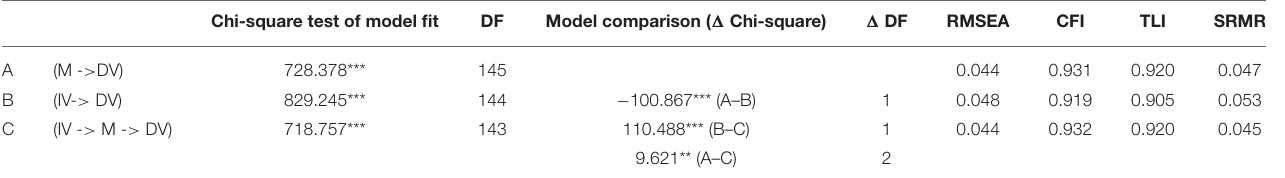
TABLE 3 | Goodness of fit indices for the distinguished models ( N =